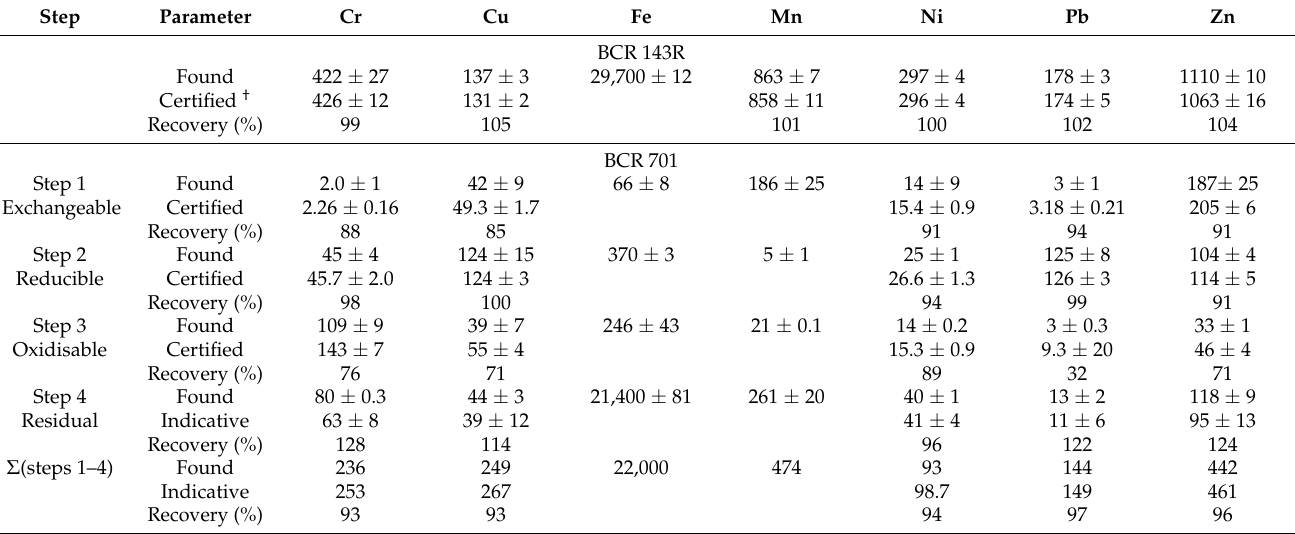
Table 2. Analysis of certified reference materials BCR 143R and BCR 701 (mg/kg dry